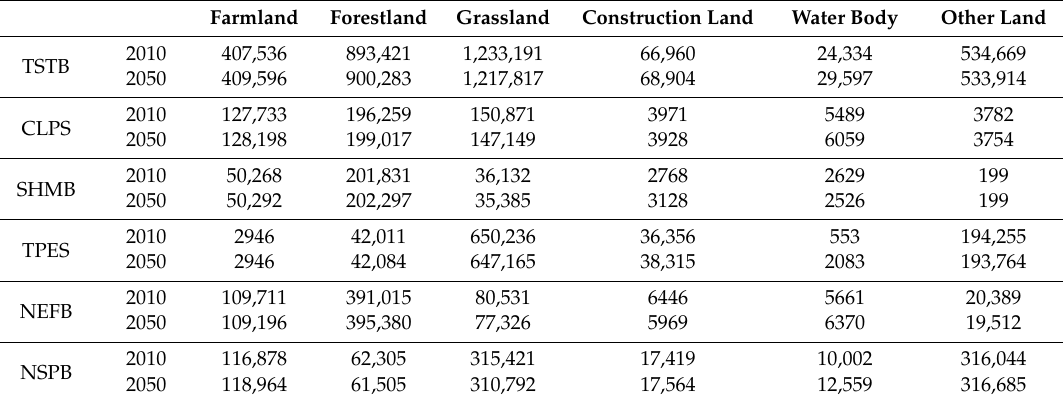
Table 1. The composition of land use types in the TSTB and each shelter in 2010 and 2050 (km 2 ). Farmland Forestland Grassland Construction Land Water Body Other